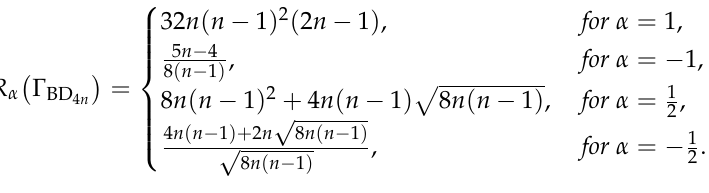
Table 3. Edge partition of Γ BD ( d v , d w ) Type